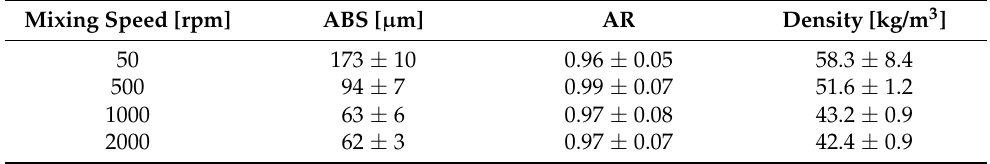
Table 4. Features of the PU samples used for the optical acquisition.